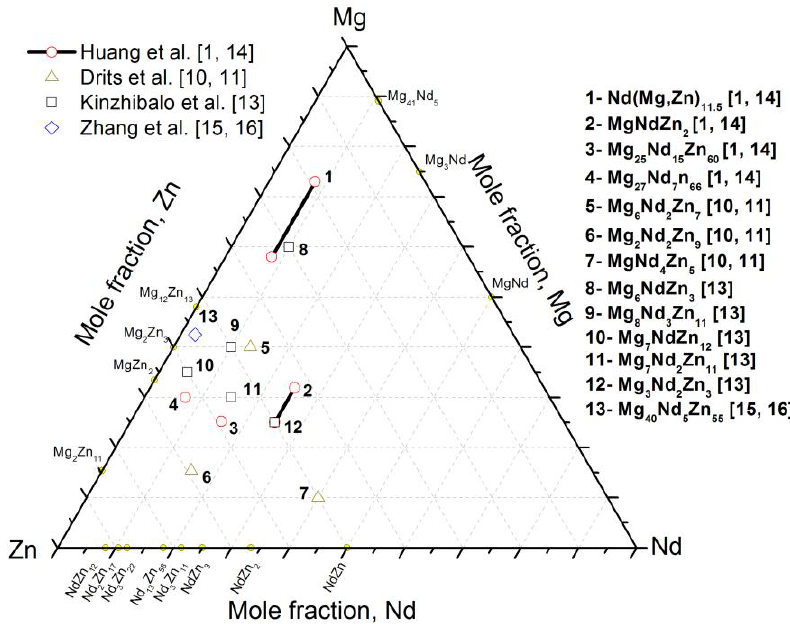
Figure 1. Graphical representation of the Mg-Nd-Zn ternary compounds reported in the literature [1,10,11,13–16] at different